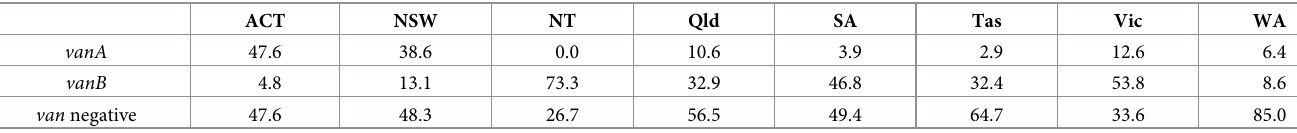
Table 2. The percentage of van genotypes across Australian states and mainland territories.